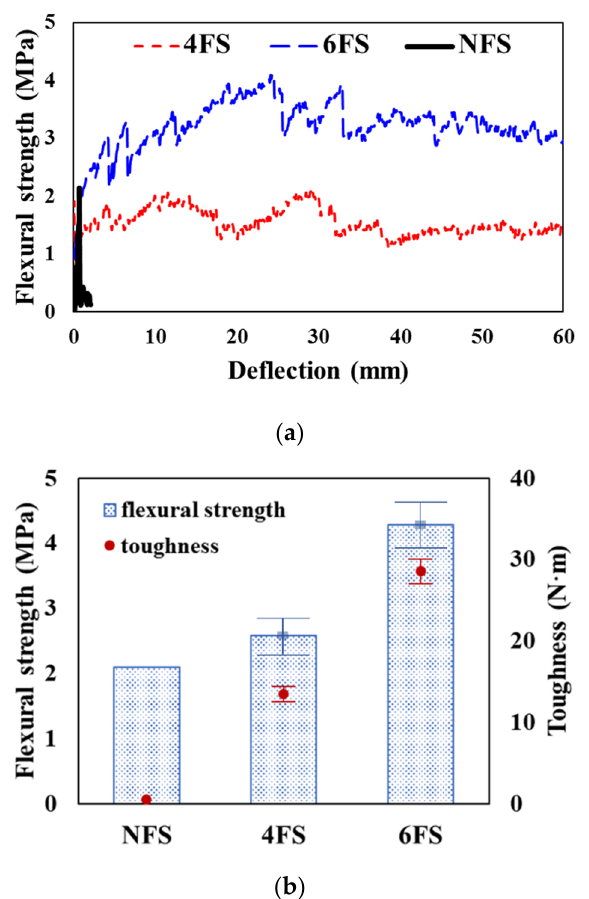
Figure 3. Flexural test results: ( a ) Flexural strength and deflection; ( b ) Flexural strength and tough- ness.